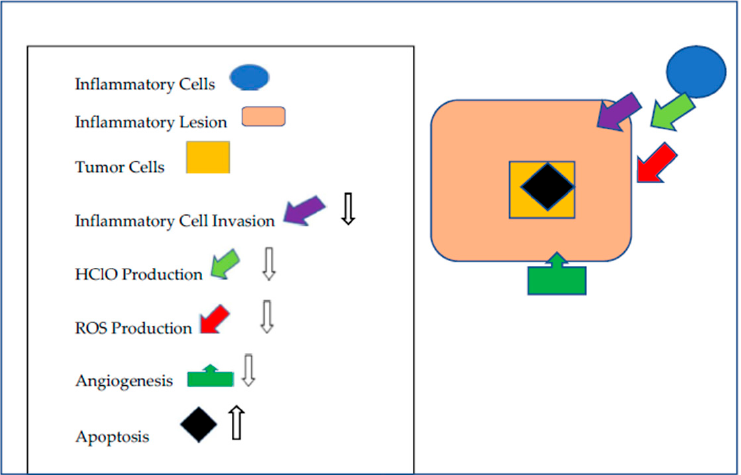
Figure 1. Mechanisms by which that Betanins Augment Cancer Chemoprevention. Betanins impede inflammatory lesion development by limiting inflammatory cell invasion, the release of HClO and the neutralization of ROS produced by the inflammatory cells and the tumor cells. Angiogenesis is moderated and apoptosis is